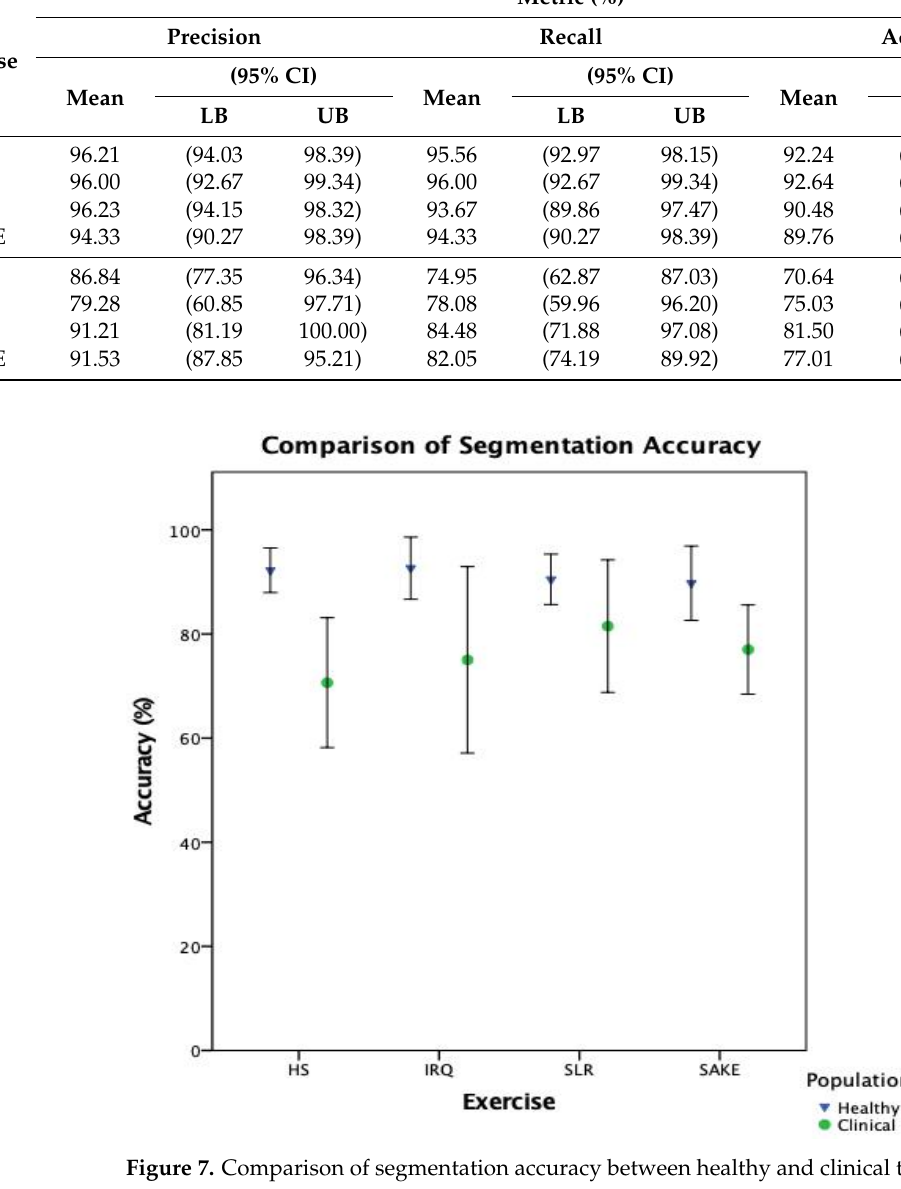
Figure 7. Comparison of segmentation accuracy between healthy and clinical test data.